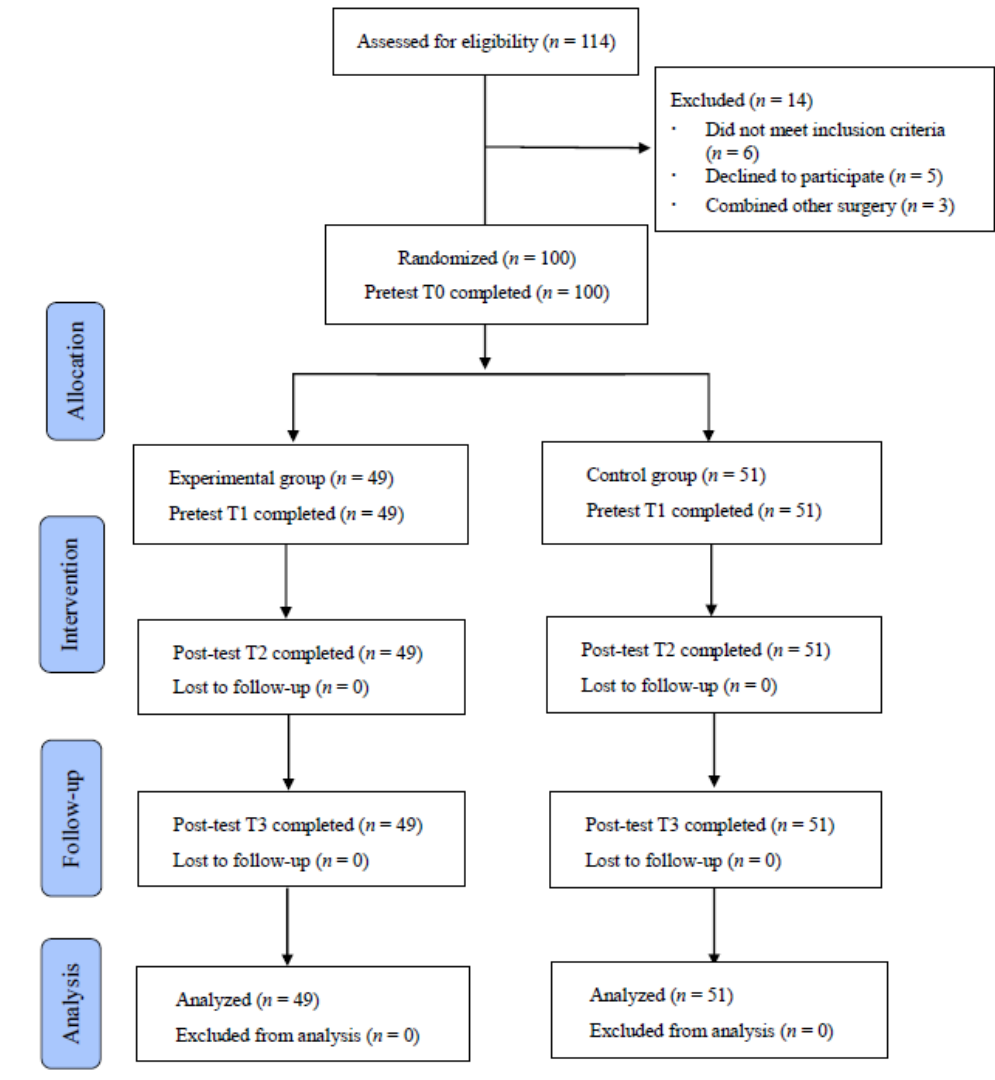
Figure 1. Research Figure 1. Research flowchart.